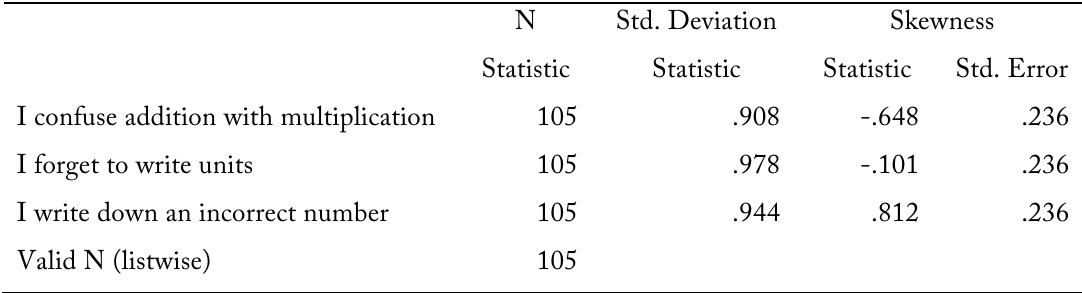
Descriptive statistical analysis N Std. Deviation Skewness Statistic Statistic Statistic Std.